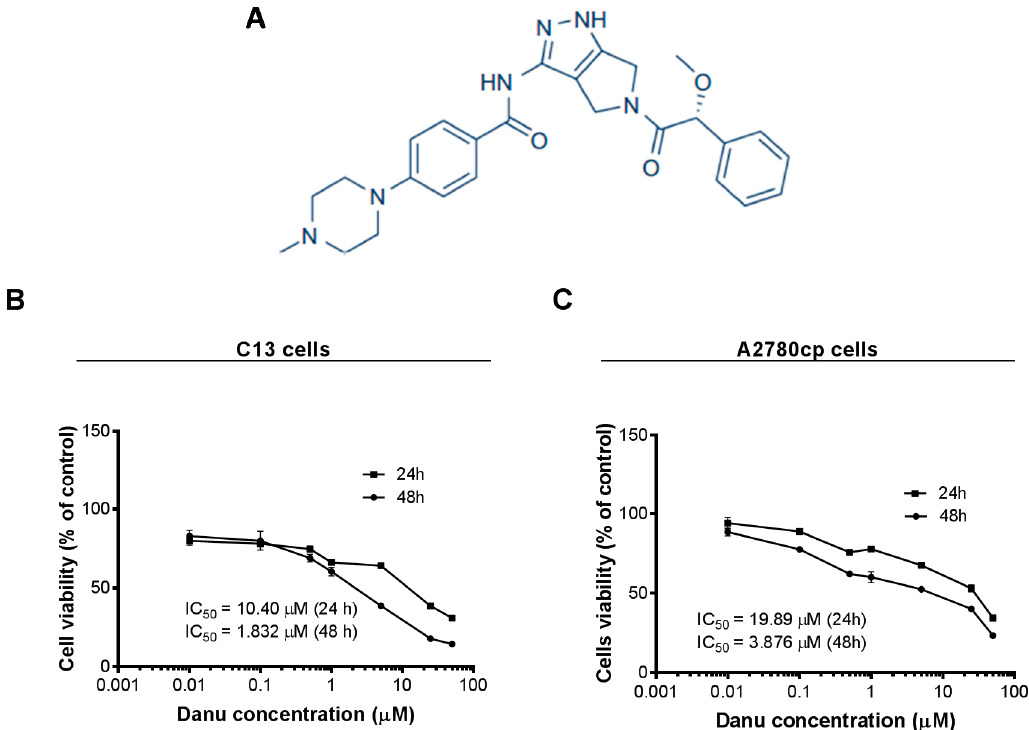
Figure 1. Chemical structure of Danu and cytotoxicity of Danu towards C13 and A2780cp cells. C13 and A2780cp cells were treated with Danu at concentrations ranging from 0.01 to 50 μ M for 24 and 48 h. ( A ) Chemical structure of Danu; ( B ) Cell viability of C13 cells; and ( C ) Cell viability of A2780cp